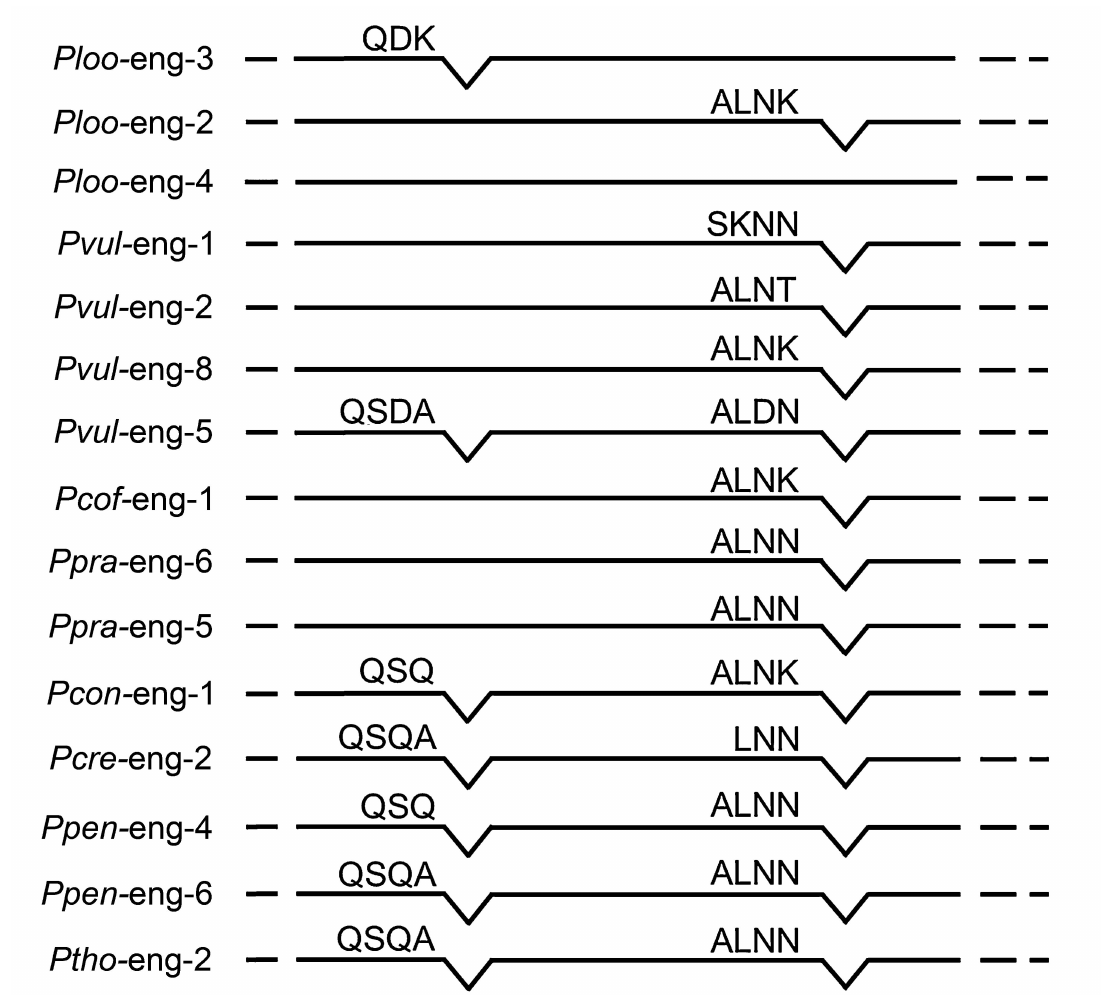
Figure 1. Schematic representation of the intron–exon structure of the Pl-eng -2, Pl- eng -3 and Pl-eng -4 genes from P. loosi compared with other Pratylenchus cellulase genes. Exons are shown as solid lines, and introns are shown as V-shaped lines. Solid V-shaped lines denoted introns located in conserved positions between nematode engs. The abbreviations indicate: Ploo: P. loosi , Pvul: P. vulnus , Pcof: P. coffeae , Ppra: P. pratensis , Pcon: P. convallariae , Pcre: P. crenatus , Ppen: P. penetrans and Ptho : P. thornei